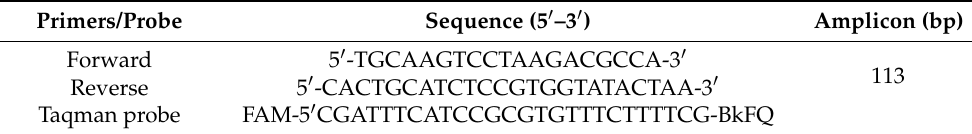
Table 1. Primers and probe sequence used in this study.